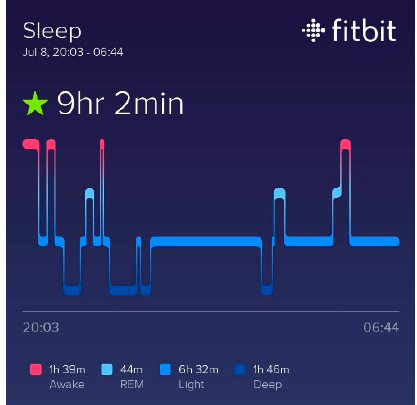
Figure A19. Bangkok, Thailand.